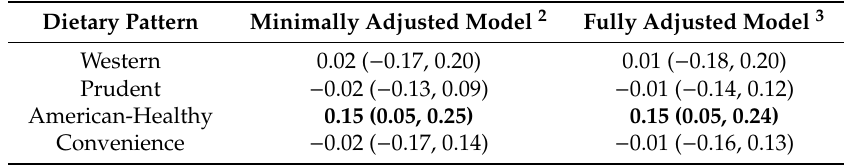
Table 4. Fact-estimated regression coe ffi cients (with 95% CI) for relationship of empirical dietary patterns with creatinine-adjusted melamine exposure 1